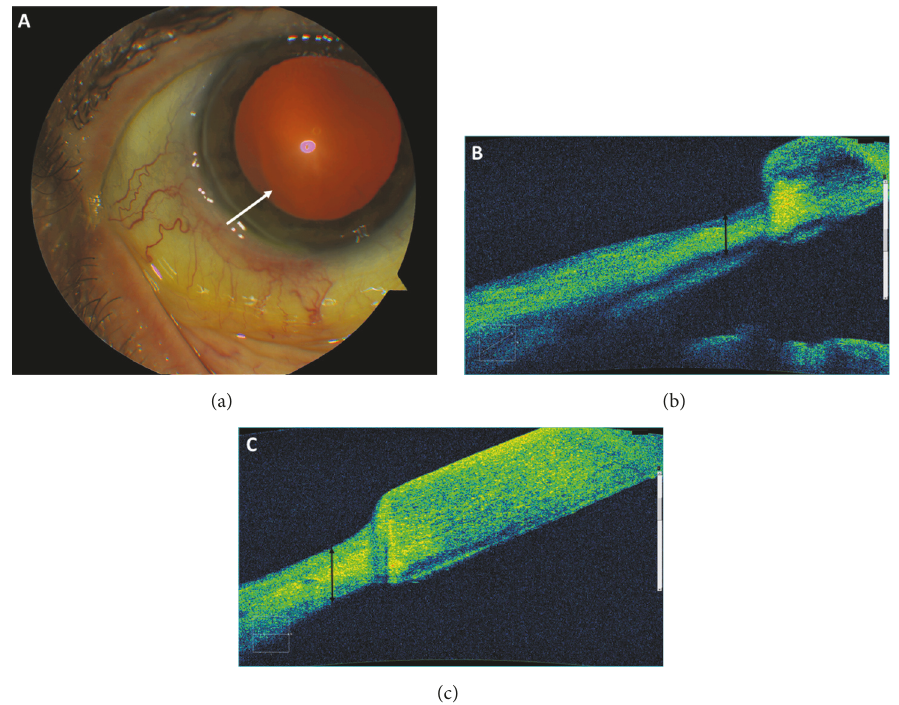
Figure 2: Inferotemporal limbal ulcer of Patient 2. Panel (a) : slit-lamp examination with white arrow drawn across primary area of thinning. Panel (b) : anterior segment optical coherence tomography (AS-OCT) image at presentation demonstrating area of significant corneal thinning(measuredat330microns)andirregularityadjacenttoanareaofrelativelynormalcornea.AsinFigure 1,theulceredgesandinterface between abnormal and normal cornea demonstrate hyperreflectivity. Panel (c) : AS-OCT six months after presentation with improvement of thinning to 450 microns after medical